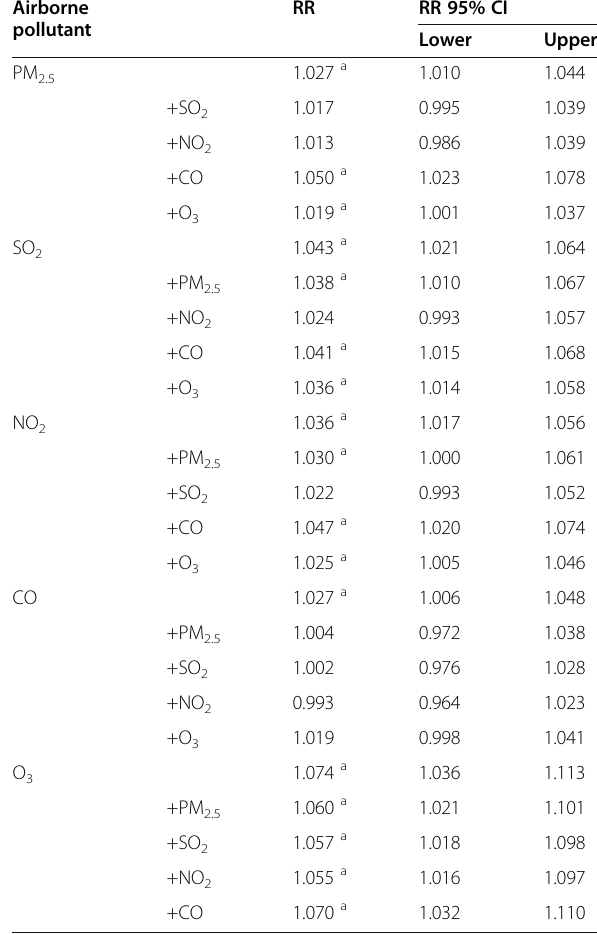
Table 3 RRs for two-pollutant models including PM 2.5 , SO 2 , NO 2 , CO, and O 3b Airborne